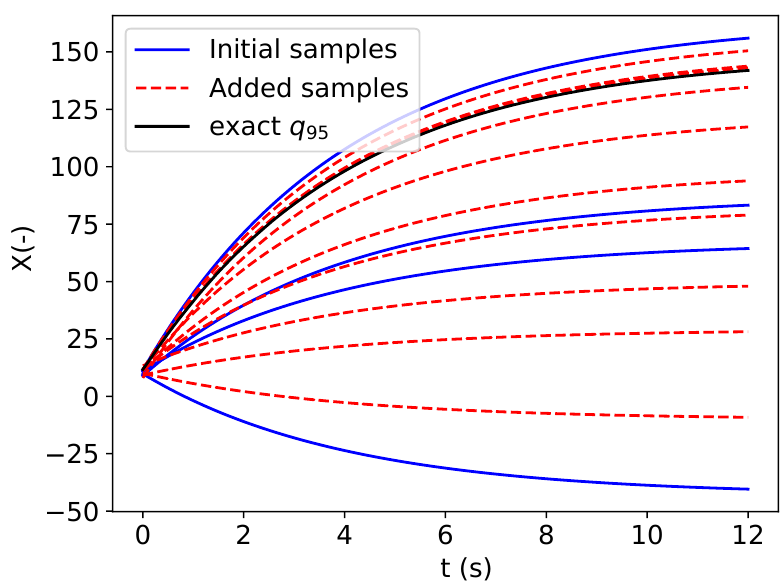
Figure 7. Initial and added output stochastic process samples in the dataset.